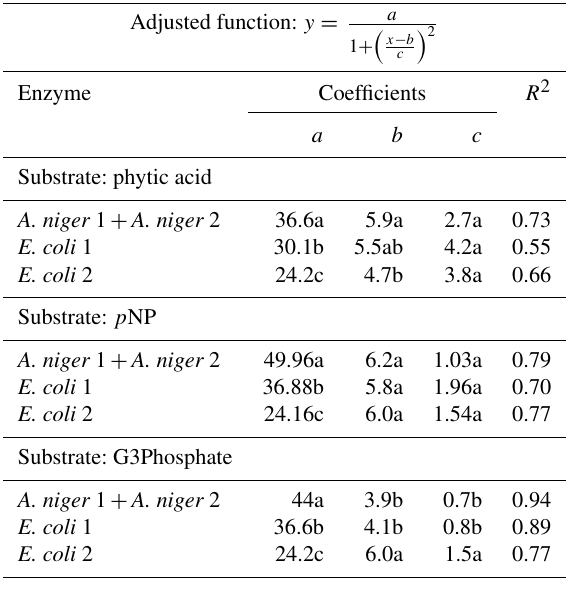
Table 2. Coefficients of the adjusted Lorentzian peak functions for phytase activity at different pH levels (see graphs in Fig. 2). The substrates used were phytic acid, p NP and G3Phosphate. Four purified phytases (two isolated from A. niger and two from E. coli ) were evaluated. In cases where significant differences between enzymes (analyzed using F tests) were not found, a unique curve was fitted. Different letters correspond to significant differences between treatments ( P< 0 . 05, least significant difference, LSD,